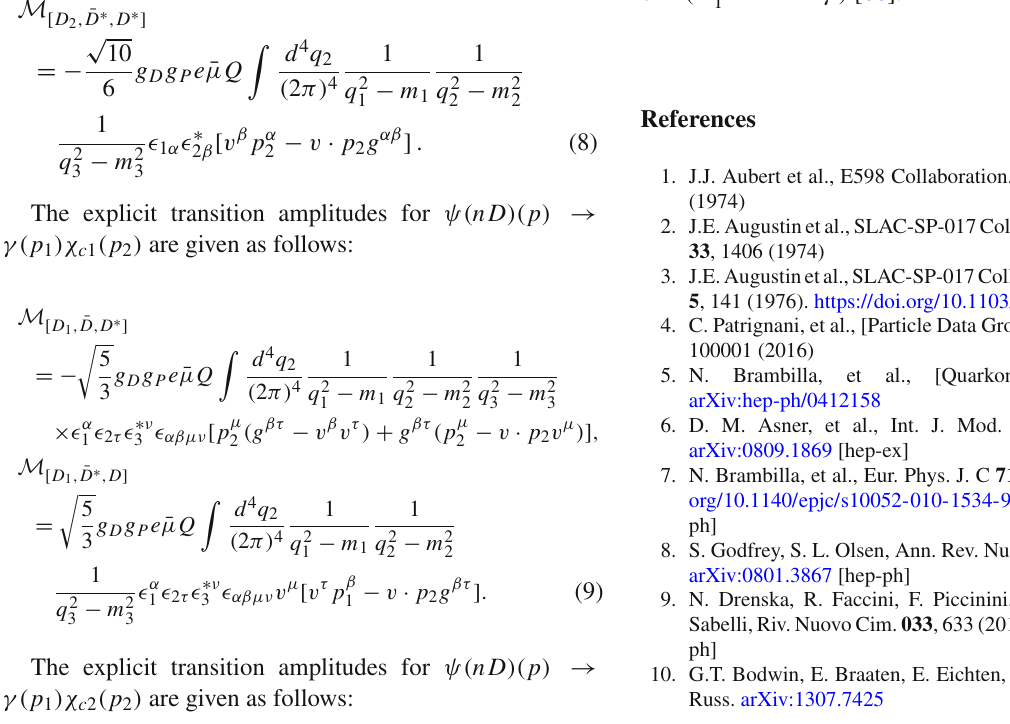
The charmonium spectrum and their strong decays into open-charm meson pairs are investigated in Refs. [74,104]. Here the coupling constants g S , g P , and g D may be deter- mined by the relevant data of Refs. [74,104]. Recently, the ψ( 4415 ) is widely accepted to be ψ( 4 S ) state. With = 12 MeV and (cid:15) ψ( = 8 . 7 MeV, (cid:15) ψ( 4415 ) → DD 1 4415 ) → D ∗ D 0 = 3 . 869GeVand weget g S (cid:7) 0 . 36G eV − 1 / 2 .With M χ c 0 ( 2 P ) = 22 . 3 MeV calculated in LP model [74,104], (cid:15) χ c ( 2 P ) → D ¯ D 0 we get g P (cid:7) 1 . 28 G eV − 1 / 2 . We get g D (cid:7) 0 . 30G eV − 1 / 2 = 9 . 8 MeV. with M ψ( 3 D ) = 4 . 486 GeV and (cid:15) ψ( 3 D ) → DD 1 ˜ β The coupling constants is relevant to radiative decay rates of the charmed mesons and can be extracted according to the ˜ β | = experimental data. We take the values of | 0 . 42 GeV − 1 estimated in Ref. [65]. There is no experimental measure- ment on the radiative decays of the P-wave charmed mesons. We take the ¯ μ (cid:7) 0 . 47 GeV − 1 with the help of the predictions → D ( ∗ ) 0 γ ) of (cid:15)( D 0 1